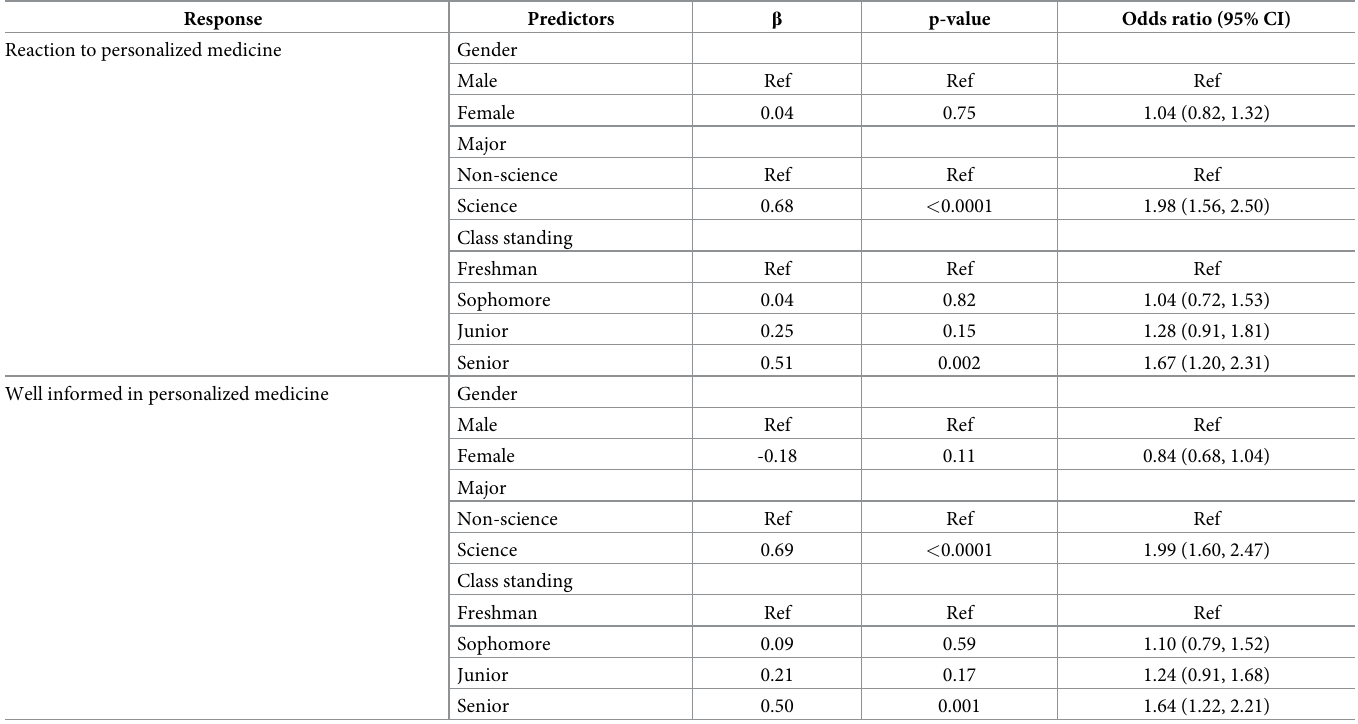
Table 4. Ordinal logistic regression results for participants’ reaction and well informed to personalized